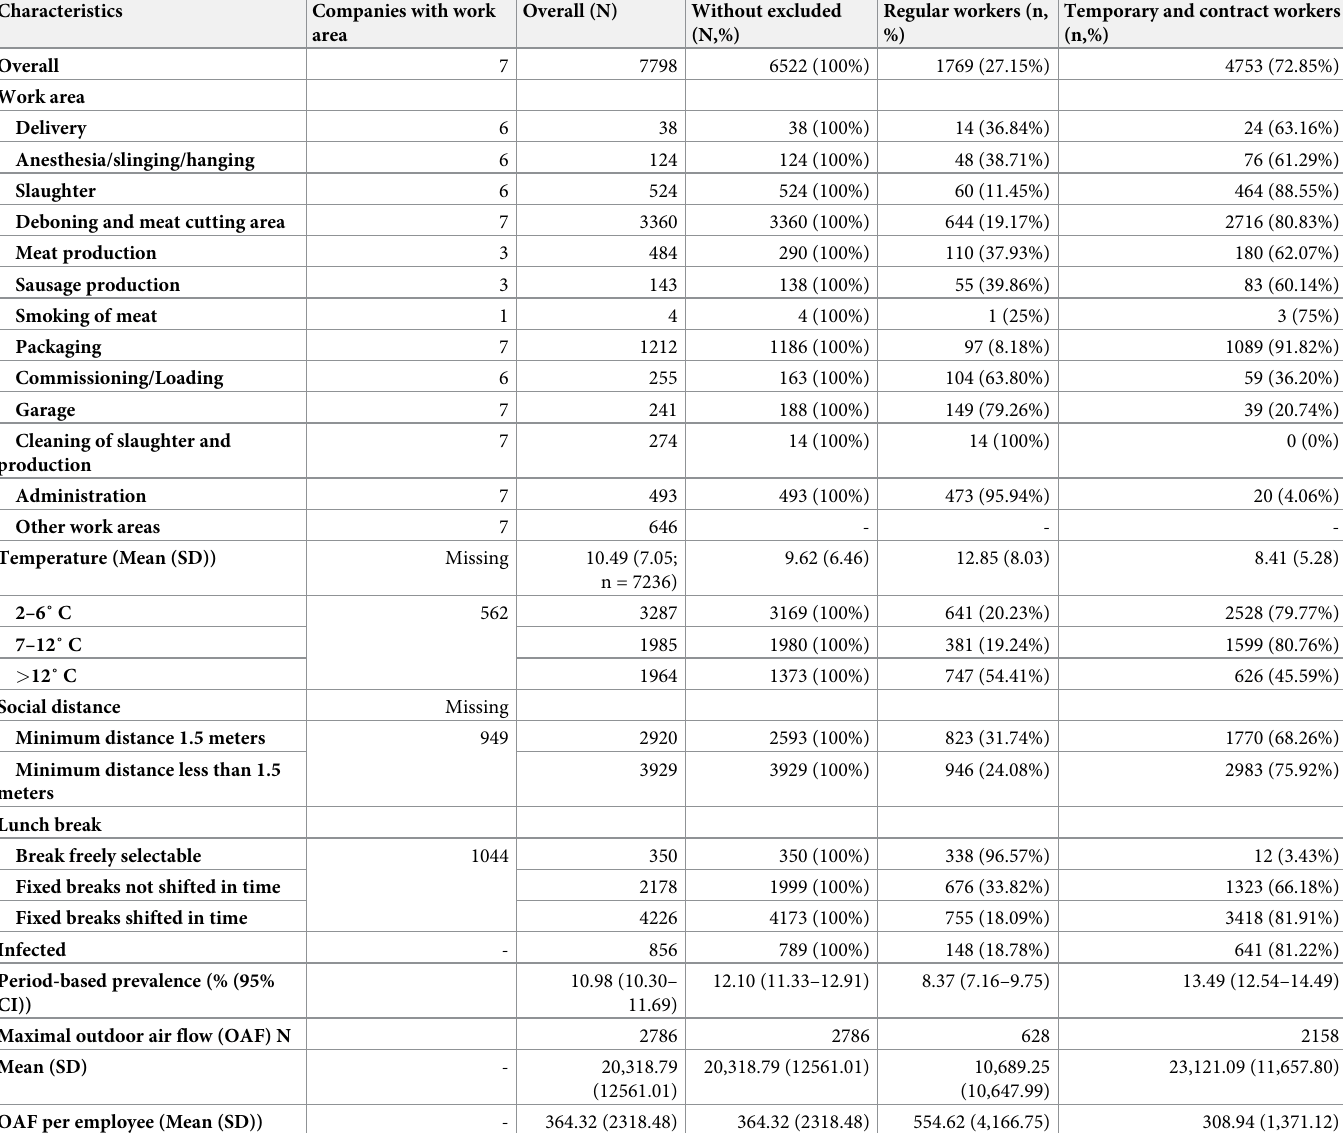
Table 3. COVID-19 among workers in meat processing plants by area of workplace in plants with many infected employees.